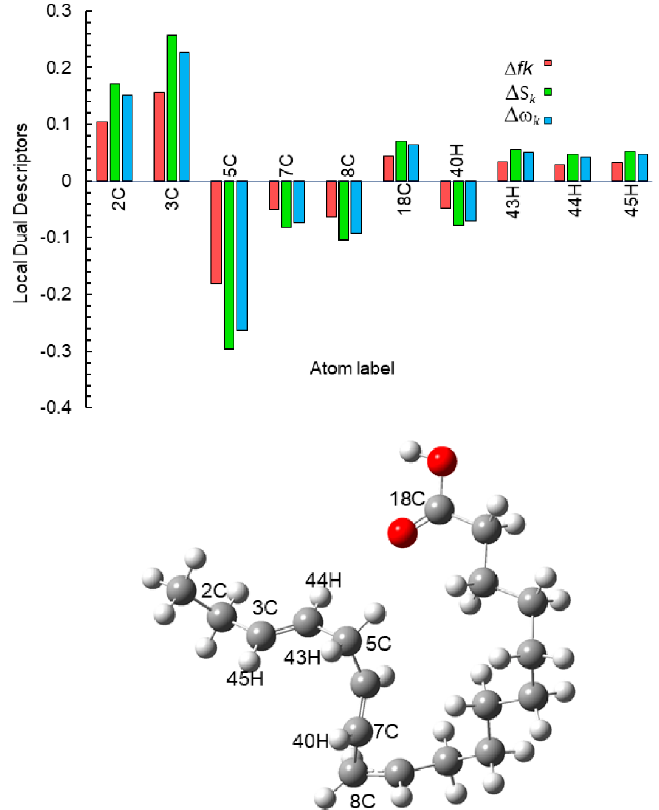
Figure 17. Graphical representation of the dual descriptors ( ∆ f k , ∆ S k and ∆ ω k ) for the most active sites of the protonated α -linoleic acid molecule.